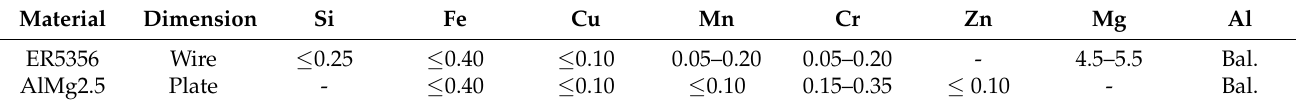
Table 2. Nominal chemical composition of the used Al wire and substrate material